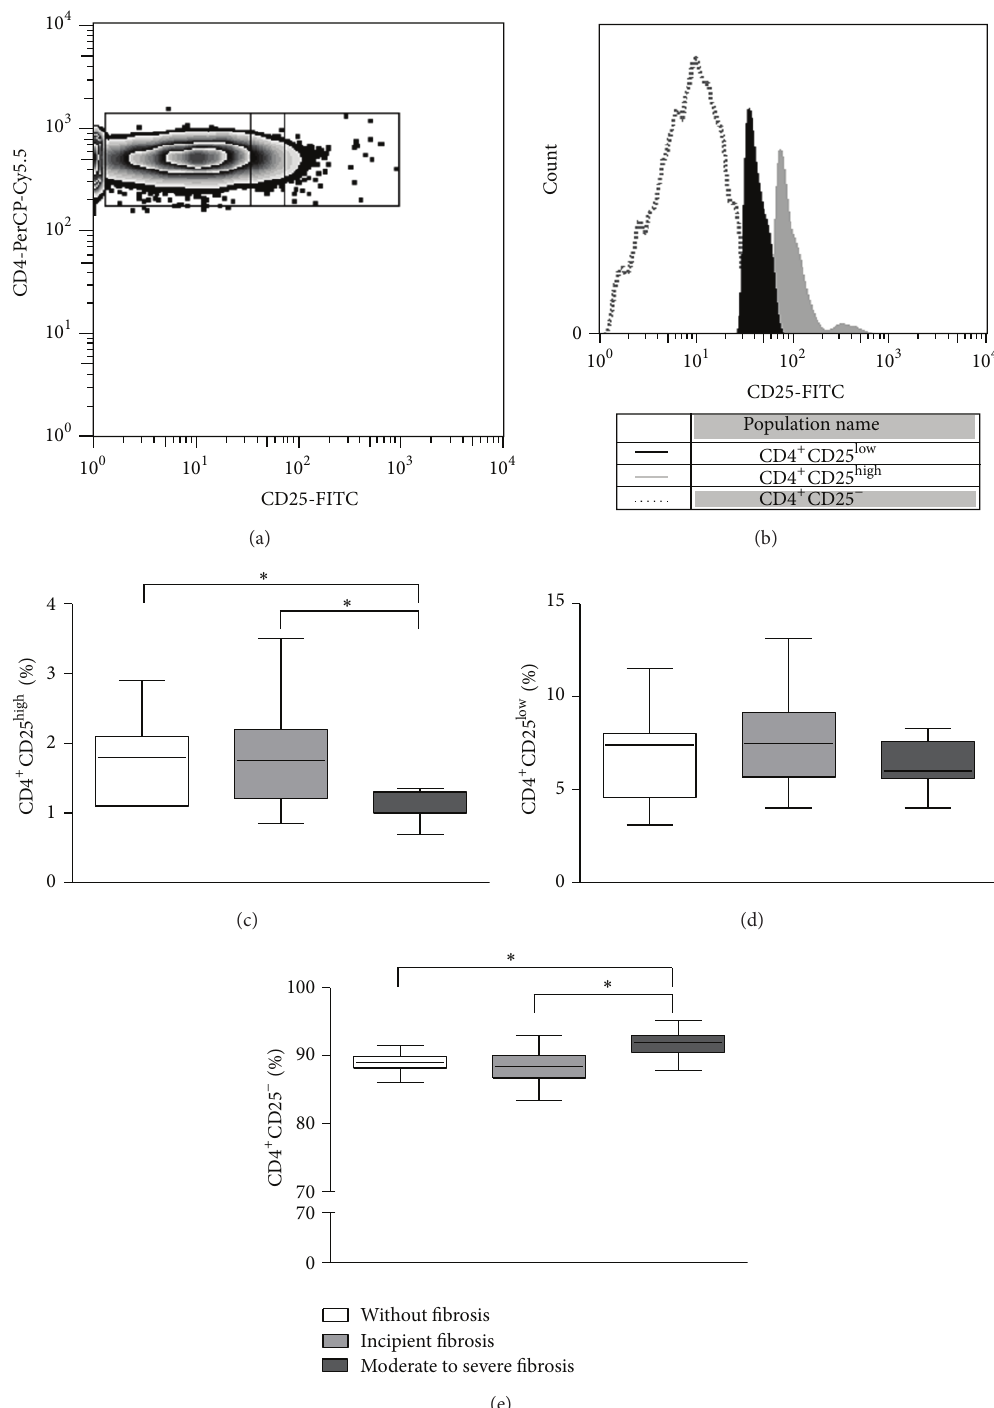
Figure 3: Frequency of T cell populations expressing CD25 molecule. Strategy to analyze the intensity of expression of CD25 molecule on TCD 4 + cells. Plot (a) and histogram (b) are representative of one experiment. Frequency of TCD 4 high (c), TCD 4 low (d), and TCD 4 neg cells (e) in individuals infected with S. mansoni with different degrees of periportal fibrosis. Ex vivo PBMC were stained for surface markers. The selection of T lymphocyte subsets was initially performed based on their forward (FSC) and side (SSC) light scatter properties, followed by immunophenotyping using a double-labeling platform with anti-CD4-APC and anti-CD25-FITC mAbs and flow cytometry. Results are expressed in median, minimum, maximum, and interquartile values of frequency ( ∗ 𝑃 < 0.05 ; Kruskal-Wallis